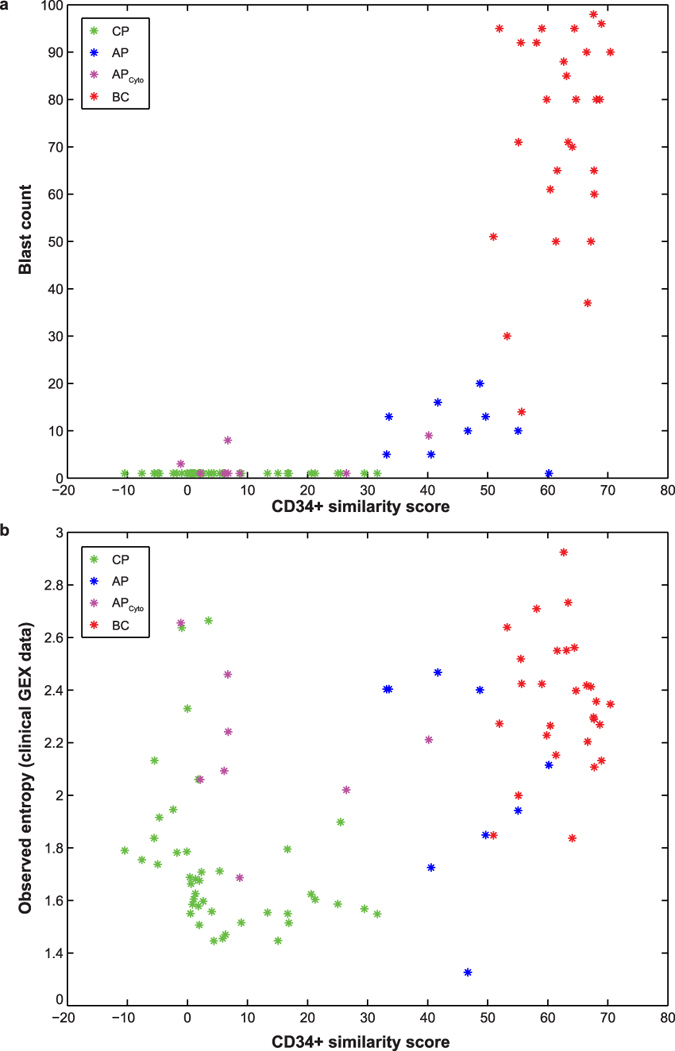
Integrated tracking of CML disease progression stages from mixed-population clinical samples.(a) Data points represent clinical samples of 42 CP (green), 9 AP (blue), 8 APcyto (purple), and 28 BC (red) patients17. Each asterisk represents one patient. Differences between patients and corresponding disease stages are resolved by CD34+ similarity score in combination with blast count. (b) Data points as in a. Entropy of patient gene expression resolves differences in disease stages in combination with CD34+ similarity score.